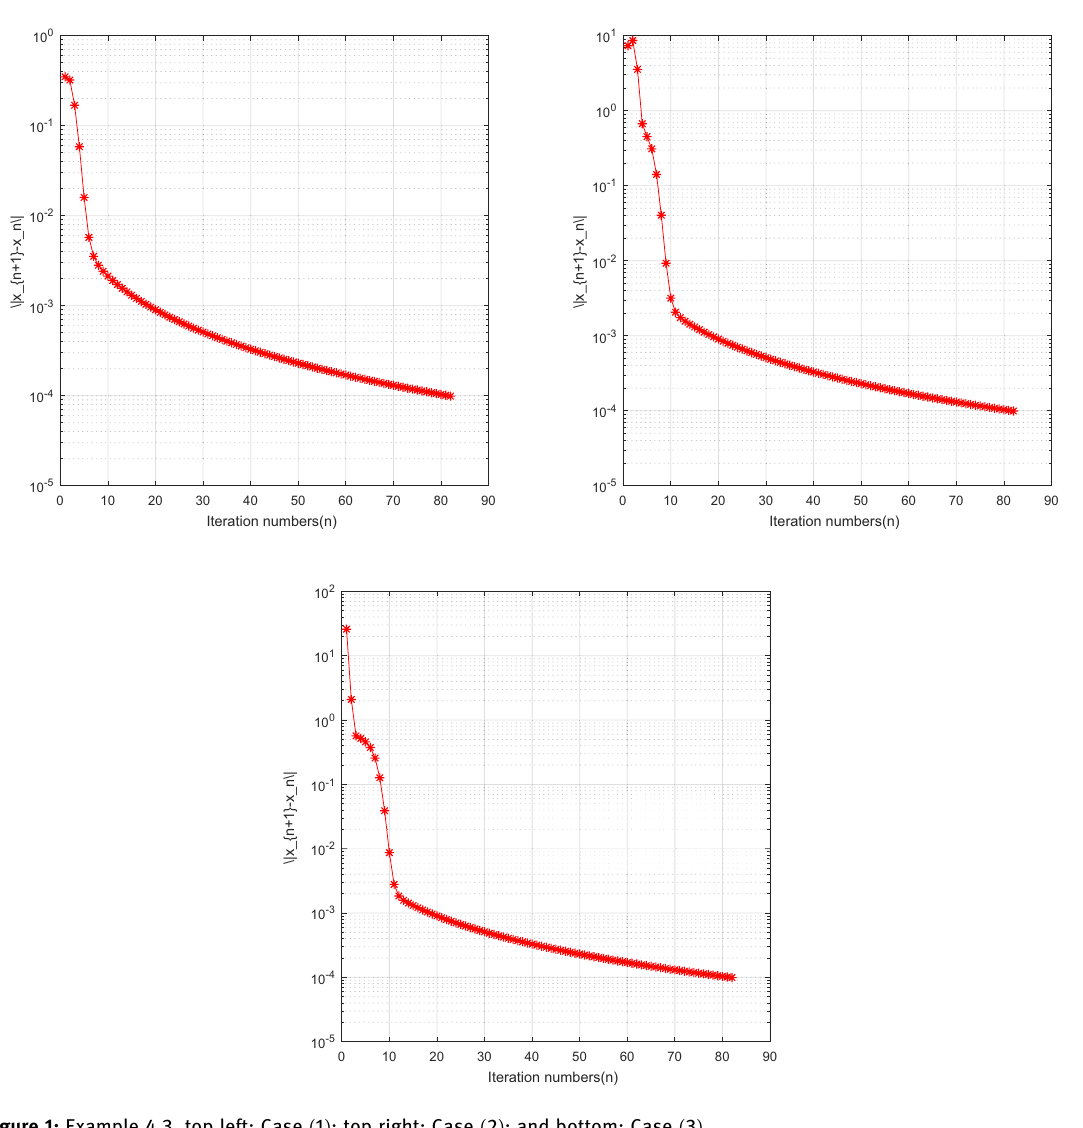
Figure 1: Example 4.3, top left: Case ( 1 ) ; top right: Case ( 2 ) ; and bottom: Case ( 3 )